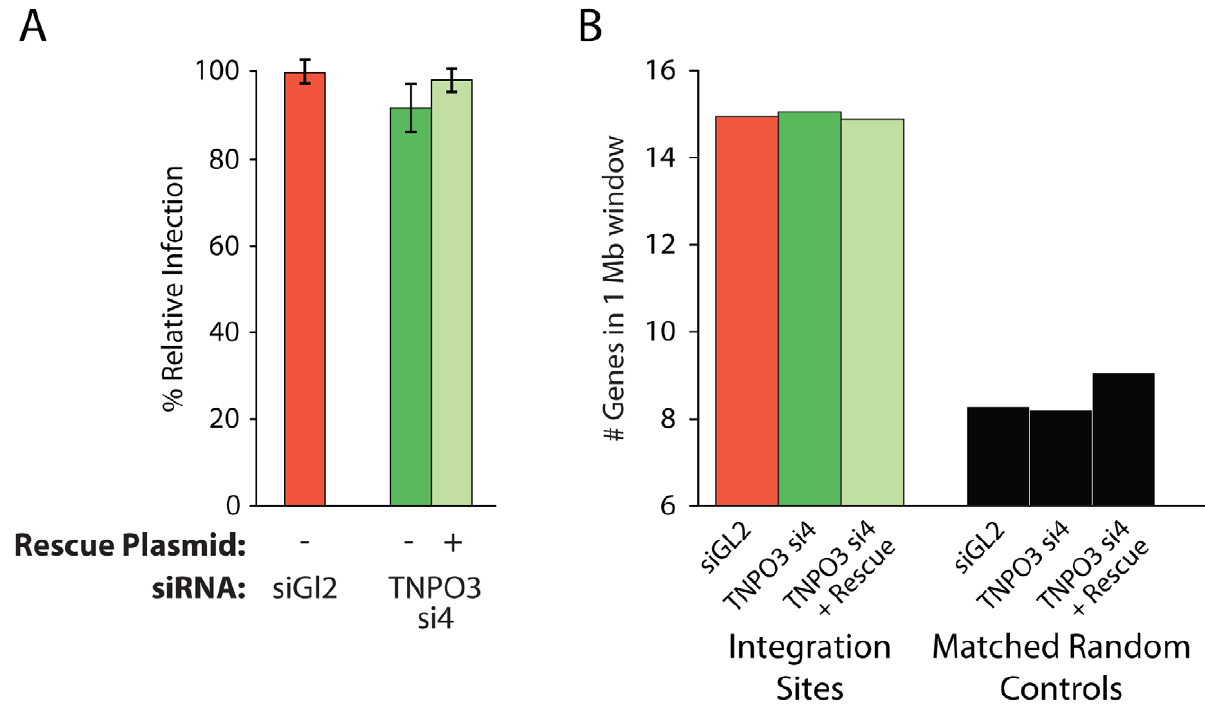
Figure 4. Depletion of Transportin-3 does not alter MLV integration targeting. (A) Infection levels of MLV in cells co-transfected with the control siRNA to GL2 plus an empty vector, TNPO3-si4 plus an empty vector, or TNPO3 si4 plus a vector encoding the siRNA-resistant Transportin-3 allele. (B) Average gene density in 1 Mb windows surrounding MLV integration sites in cells depleted or rescued for Transportin-3 expression. No sets showed significant differences from GL2-treated cells as determined by the Mann–Whitney